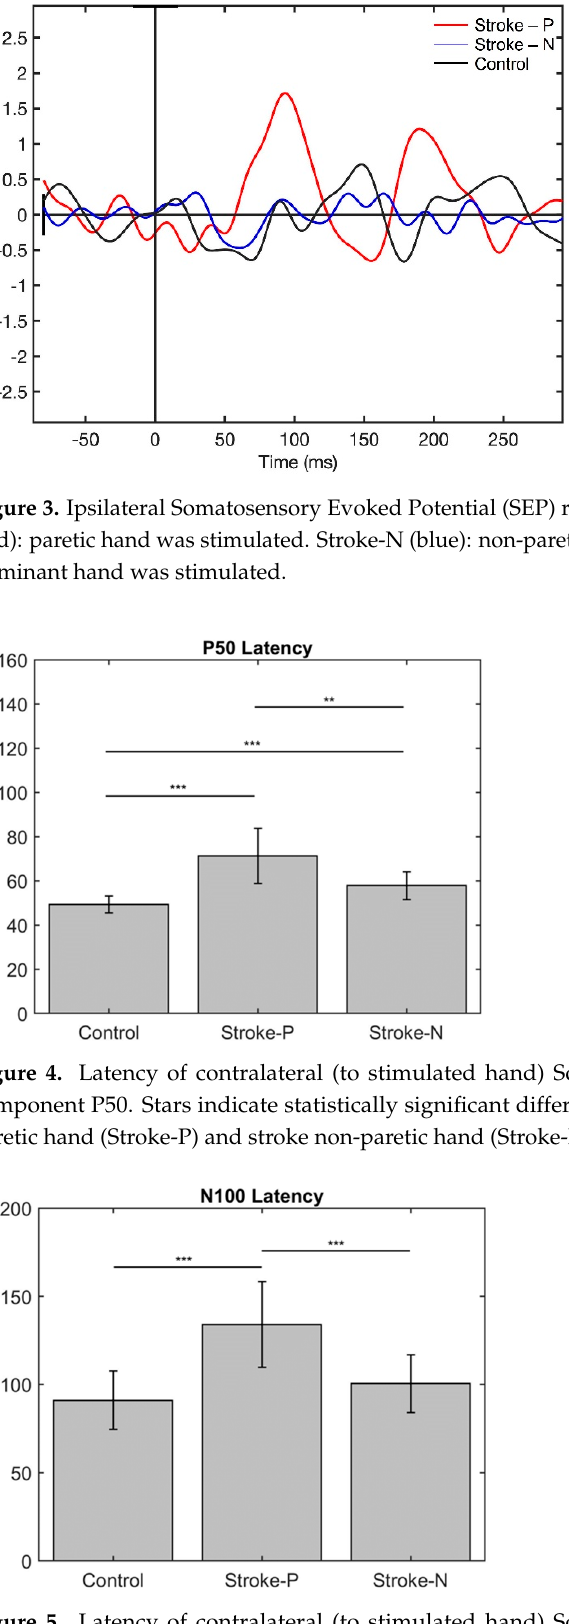
Figure 5. Latency of contralateral (to stimulated hand) Somatosensory Evoked Potential (SEP) component P50. Stars indicate a statistically significant difference between groups (control, stroke paretic hand (Stroke-P) and stroke non-paretic hand (Stroke-N)): *** < 0.001. The amplitude differences of P50 and N100 in the contralateral (to stimulated hand) hemisphere were not statistically significant between stroke and control groups. The mean values of amplitude are reported in Table 2. The Pearson correlation analysis showed that there was a significant negative linear relationship between the P50 amplitude of the con- tralateral (to stimulated hand) SEP responses and Fügl–Meyer upper extremity (FM-UE) score (R = − 0.630, p = 0.047), as shown in Figure 6. No significant correlations were found between FM-UE and other SEP measures. Figure 6. Stroke paretic hand: Fügl–Meyer upper extremity (FM-UE) score vs. P50 amplitude in the contralateral (to stimulated hand) hemisphere. There is a significant negative linear relationship between P50 amplitude and FM-UE Score (R = − 0.630, p = 0.047). The laterality index (Figure 7) was significantly lower when the stroke paretic hand was stimulated compared to the stroke non-paretic hand (z = − 2.44, p = 0.033) and healthy control ( p = 0.022), indicating more bilateral or ipsilateral cortical activities after a stroke. This was also evident in source localization results where only contralateral source activ- ity was detected in healthy controls, which was in line with previous findings [23,30,31], while bilateral source activities were shown in individuals after a stroke (Figures 8–10).